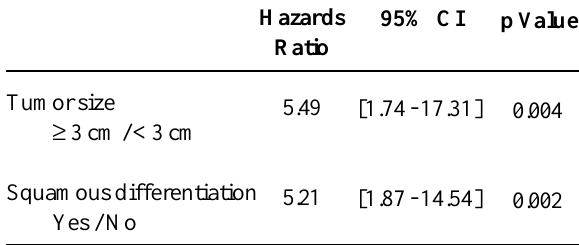
Table 4 – Multivariate Cox regression analysis for cancer- specific